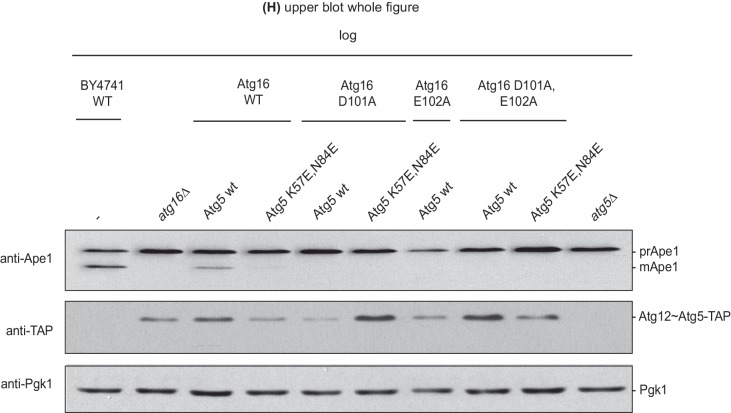
Effect of the disruption of the Atg16 – Atg21 interaction on prApe1 processing.prApe1 processing assay in atg16Δ yeast strain expressing transiently transformed Atg16 D101A or E102A or D101A,E102A-double mutant proteins and Atg5-TAP or Atg5 K57E,N84E-TAP stably integrated in the genome (complete blot from Figure 5H upper blot). The Atg5 K57E,N84E-TAP in combination with Atg16 wild type shows reduced prApe1 processing. This mutant, in combination with Atg16 D101A,E102A and D101A,E102A-double mutation, shows fully arrested prApe1 processing. Atg5 expression levels were checked using anti-TAP-antibody; Pgk1 served as a loading control.